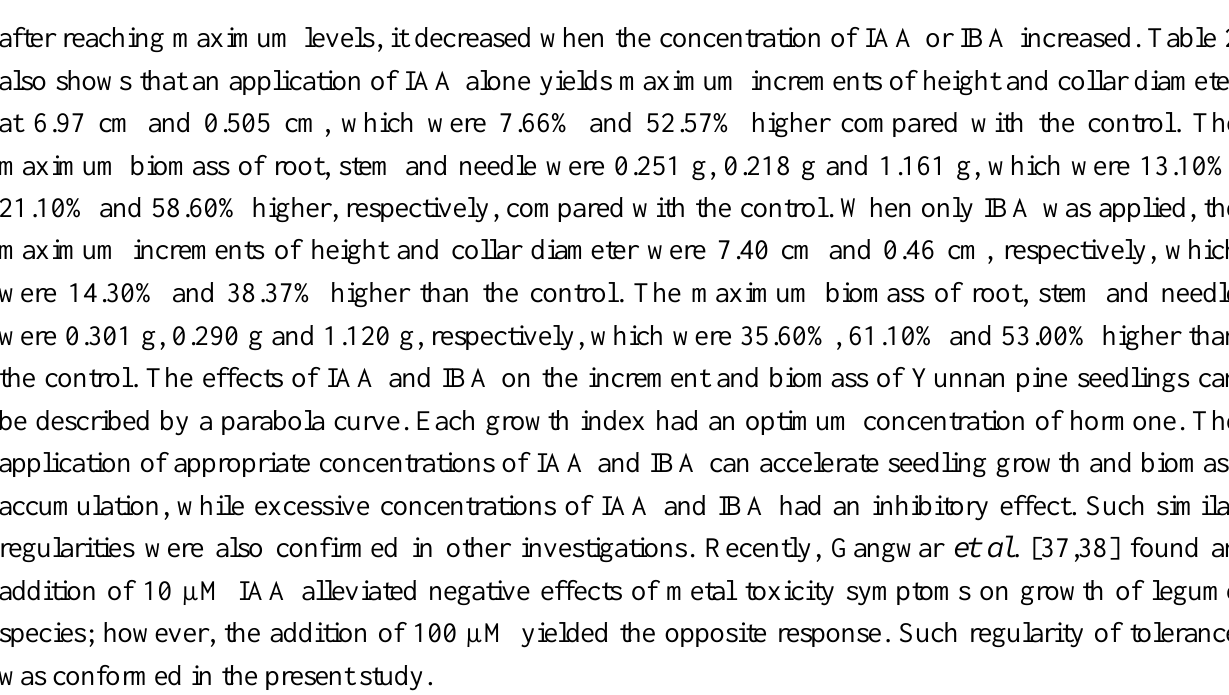
Table 2. One-factor equations of IAA and IBA on the growth index of Yunnan pine seedlings. Growth index( Y ) One-factor equation